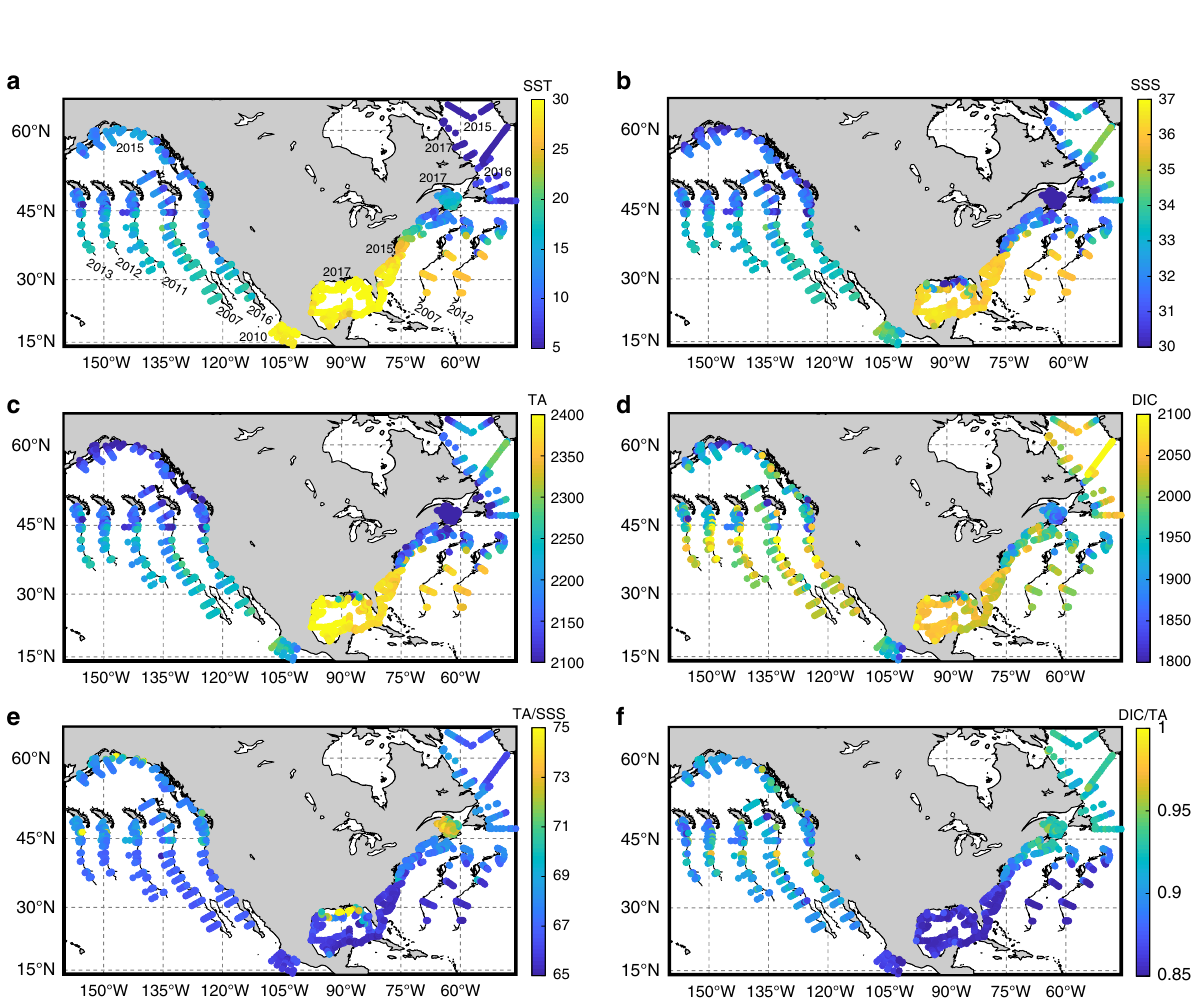
Fig. 2 Distributions of physical and biogeochemical parameters. These parameters are important to understand the marine carbonate system in surface seawater along the North American margins. a Sea surface temperature (SST), b sea surface salinity (SSS), c total alkalinity (TA), d total dissolved inorganic carbon (DIC), e TA/SSS ratio, and f DIC/TA ratio. See the “ Methods ” section for details about the measurement or calculation of these parameters. To conserve space, only the 2015 – 2017 data are presented in their exact geographic locations on a North American ocean margin map,